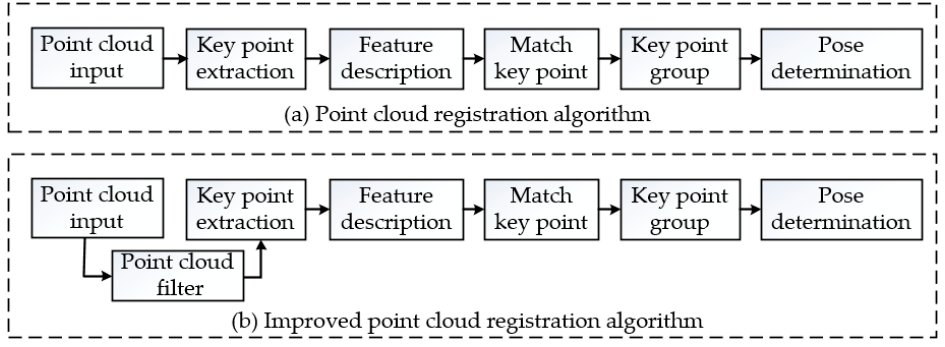
Figure 10. Flowchart of pose determination.